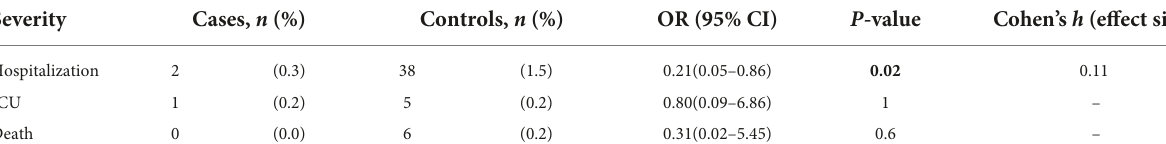
TABLE 3 Hospitalizations, ICU admissions, and deaths in cases and controls.